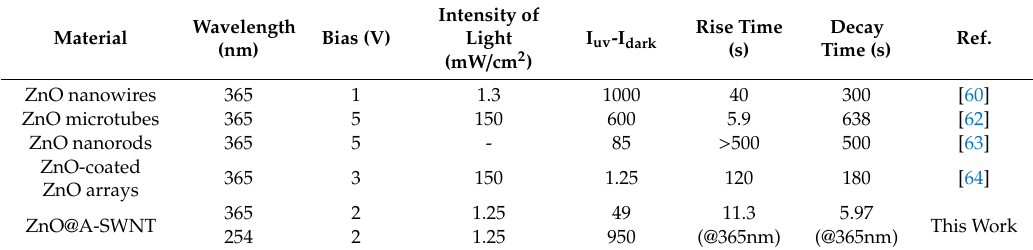
Figure 10. ( a ) Spectral responsivity of the ZnO@A-SWNT UV PD, photoresponses of the ( b ) ZnO NPs and ( c ) ZnO@A-SWNT PDs under UV irradiation (365 nm, 0.47 mW/cm 2 ) at a voltage bias of 2V. The insets in ( b ) and ( c ) show the recovery times of ZnO NPs and ZnO@A-SWNT PDs, respectively. On/off switching properties with time-dependent measurements for ( d ) ZnO NPs and ( e ) ZnO@A-SWNT PDs. Table 2. Comparison of performances for various ZnO-based UV PDs.